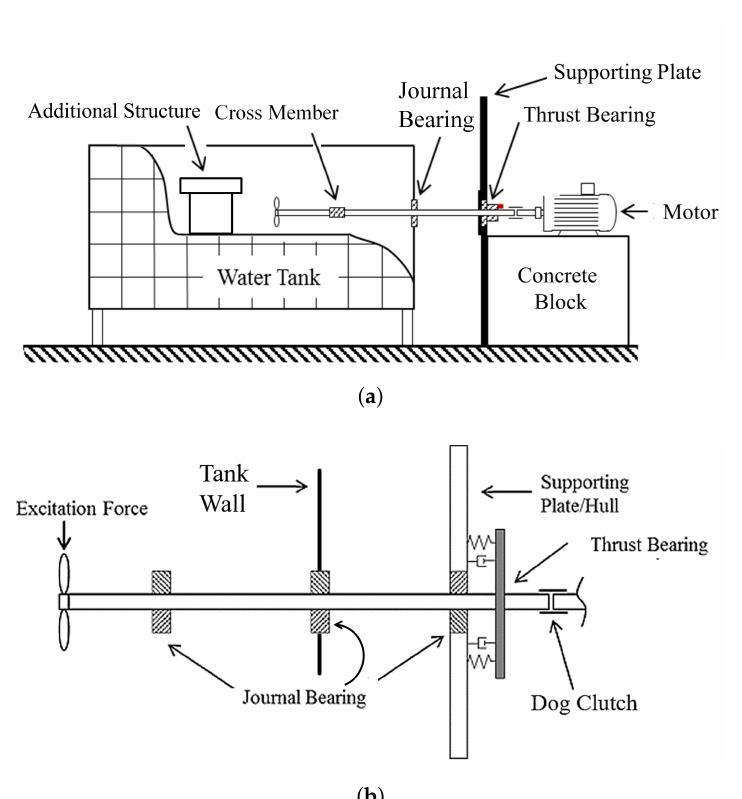
Figure 1. Schematic of the experimental rig ( a ), enlarged view of propulsion system ( b